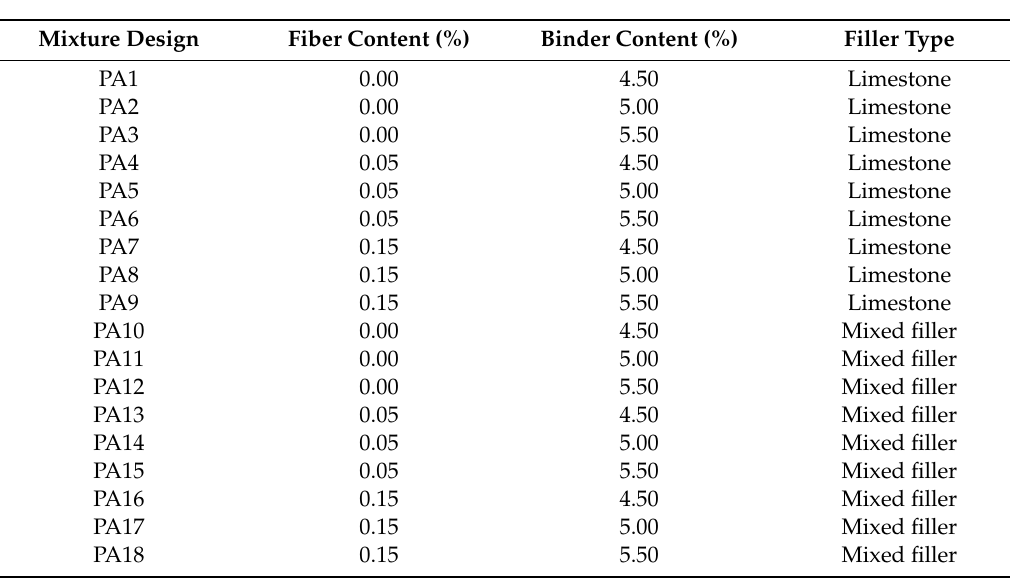
Table 6. Full factorial design with Taguchi orthogonal array